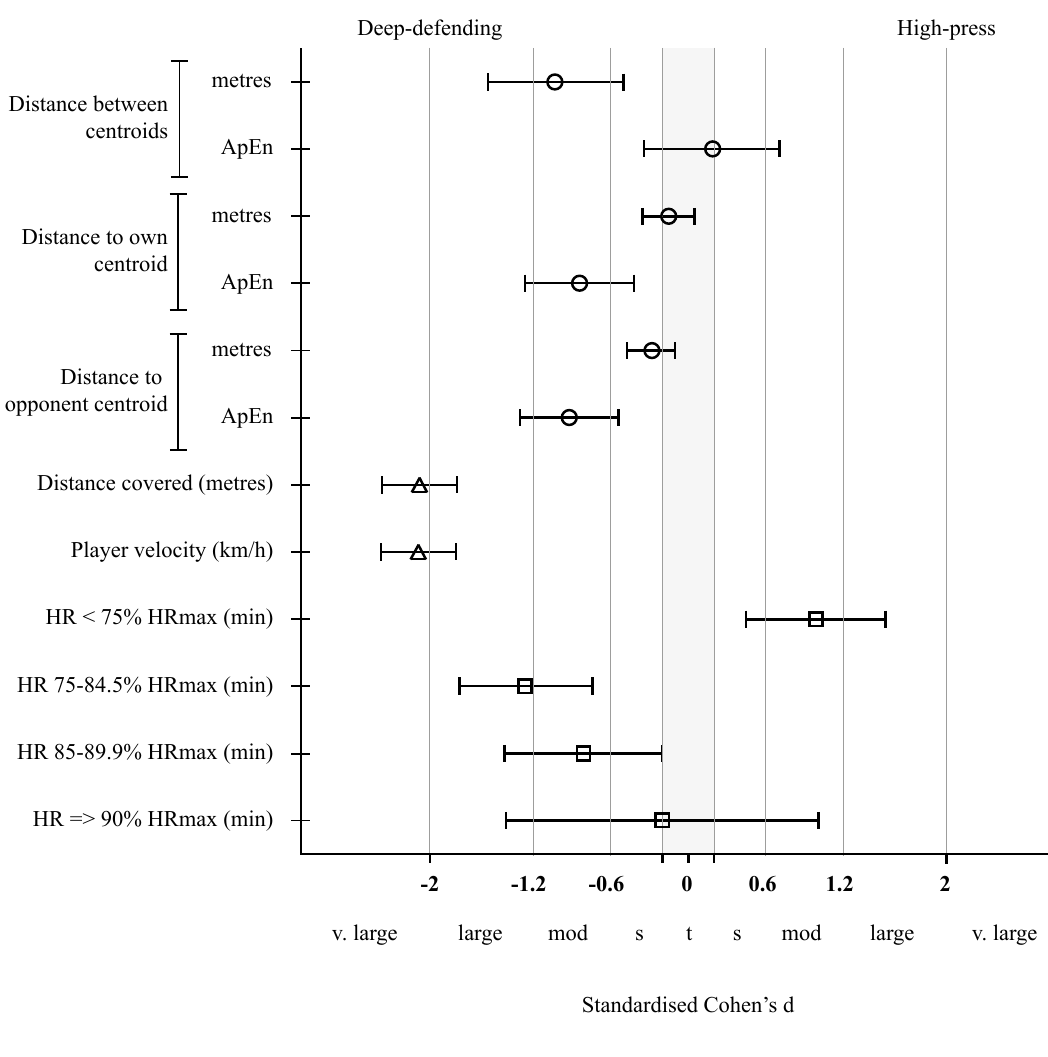
Figure 1. Standardised Cohen’s differences in tactical, physical and physiological variables according to deep-defending vs high-press. Error bars indi- cate uncertainty in true mean changes with 90% confidence intervals. ApEn=Approximate Entropy; t=trivial; s=small; mod=moderate; HR=heart rate.